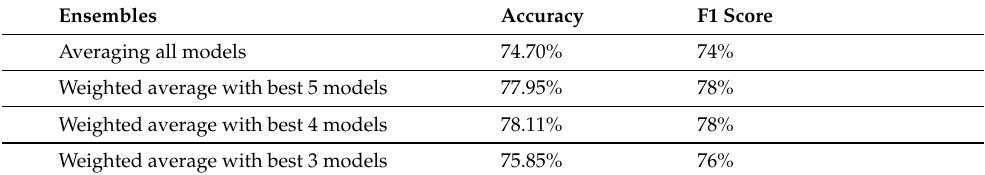
Table 19. Ensembles for ACR classification.